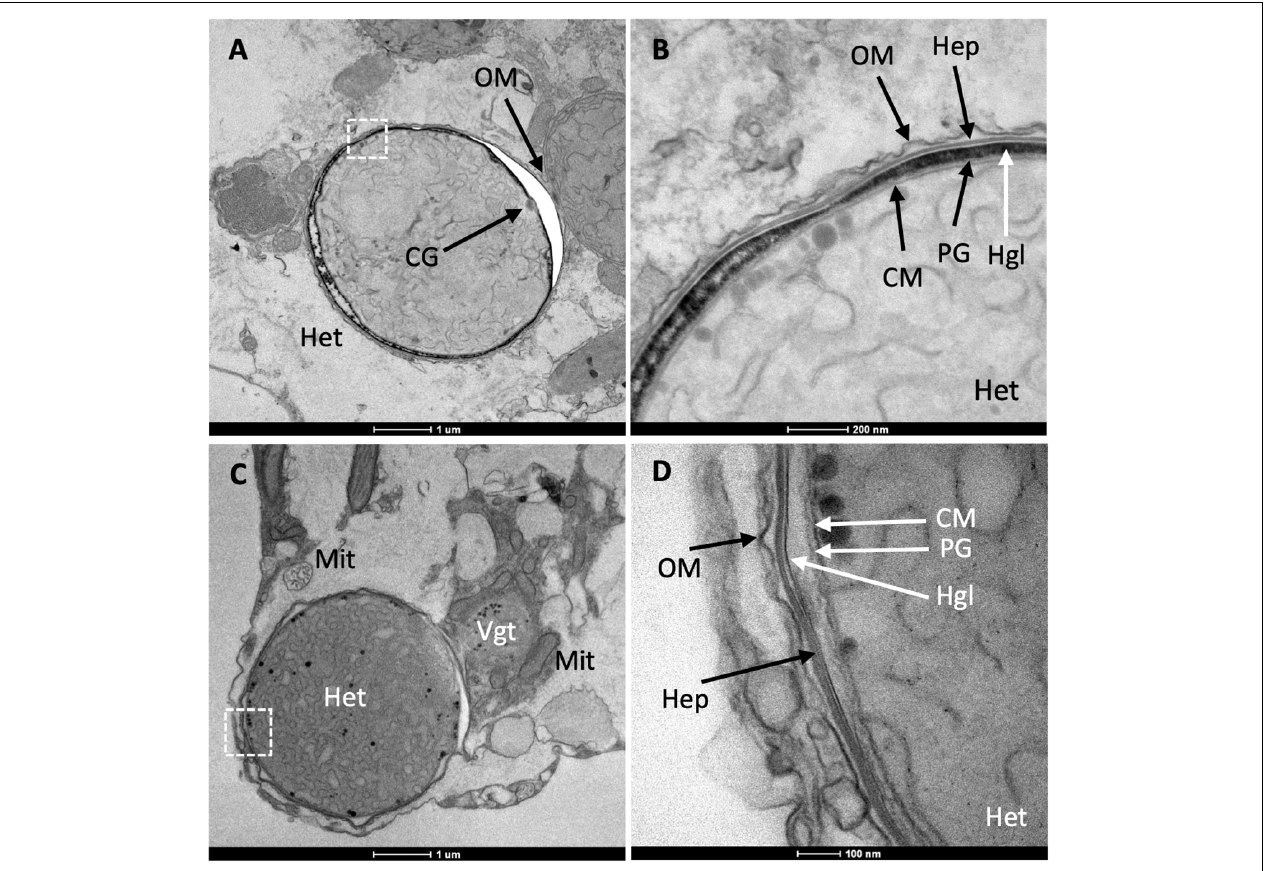
FIGURE 6 | Transmission electron micrographs of R. intracellularis heterocysts and details of the heterocyst envelope. (A) Magnified view of the left-hand heterocyst (Het) in Figure 2A . Note the outer membrane (OM), which is continuous with that of the adjacent vegetative cell, and the presence of a possible cyanophycin granule (CG); the relative accumulation of membranes close to the CG resembles the heterocyst honeycomb structure. (B) Magnified view of part of the envelope from the heterocyst shown in panel (A) (dotted square). Note the presence of cytoplasmic membrane (CM) and outer membrane (OM). Three additional layers tentatively identified as peptidoglycan layer (PG), glycolipid layer (Hgl) and polysaccharide layer (Hep) are shown. (C) Part of a diatom cell in which a heterocyst (Het) and part of an adjacent vegetative cell (Vgt) can be observed. Note the presence of nearby mitochondria (Mit). (D) Magnified view of part of the envelope from the heterocyst shown in panel (C) (dotted square). Heterocyst envelope layers tentatively identified as cytoplasmic membrane (CM), peptidoglycan layer (PG), glycolipid layer (Hgl), polysaccharide layer (Hep) and outer membrane (OM) are indicated. Note that the putative glycolipid layer is thinner in this image than in that shown panels (A,B)